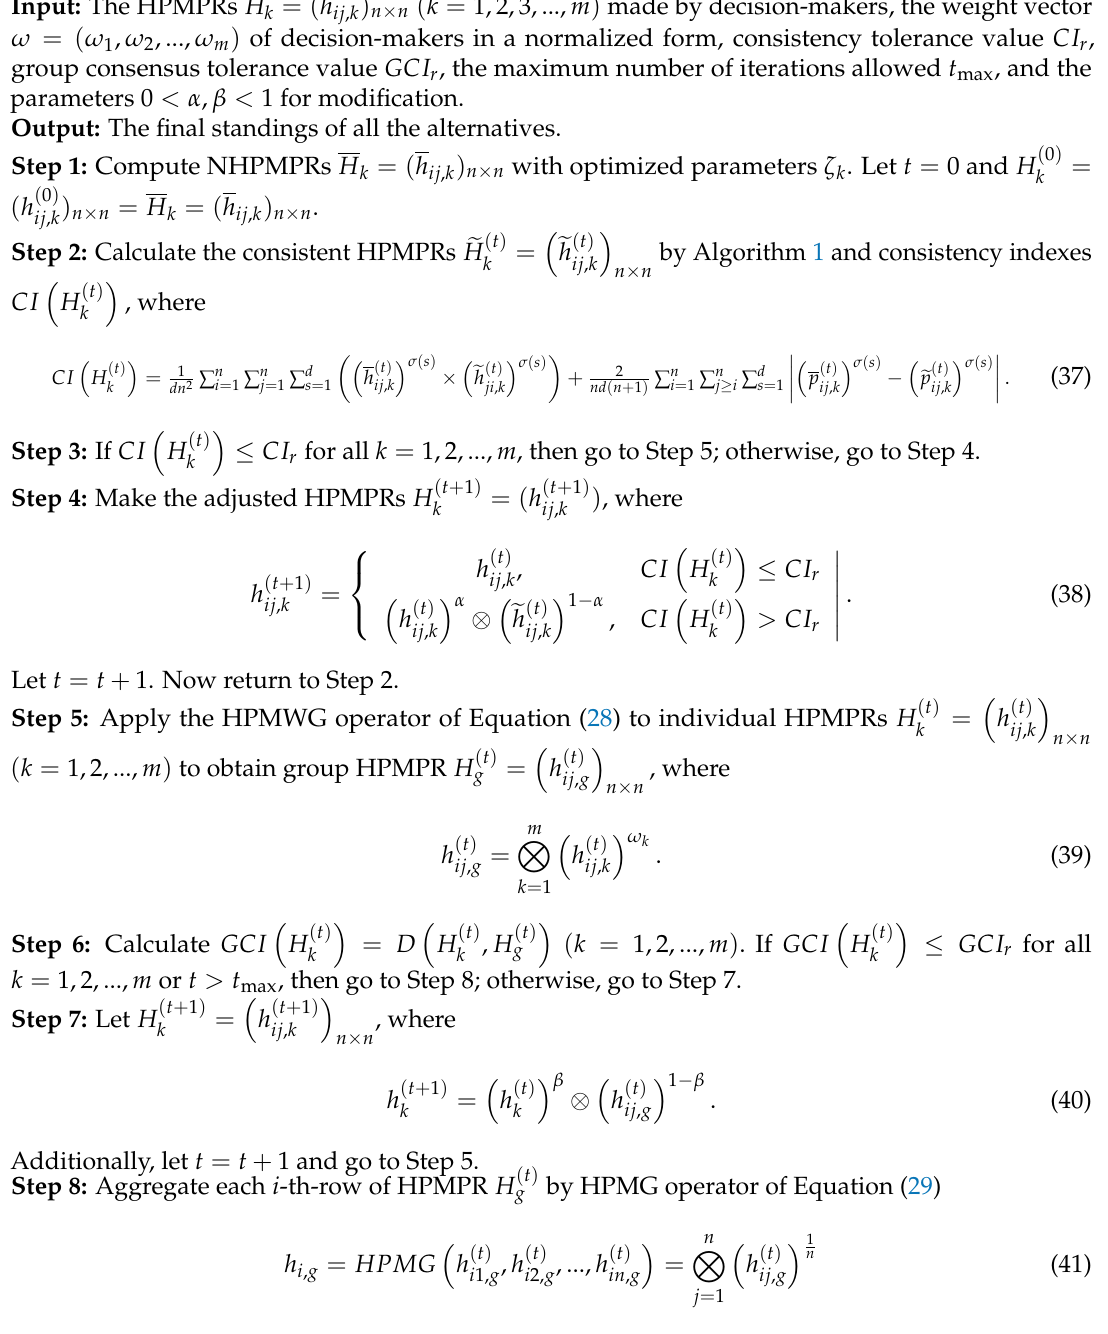
Algorithm 4 Algorithmic description to determine a complete decision